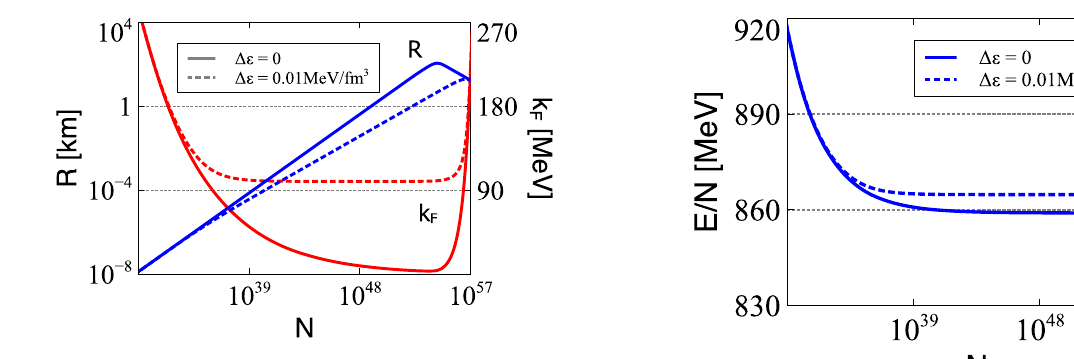
Fig. 4 The radius and Fermi momentum as a function of N at fixed Δ(cid:8) . Note that N (cid:2) M / M (cid:2) 1 . 2 × 10 57 Sun Sun Nucleon E surface with respect to the surface thickness d and the radius R at a fixed value of the total number of Λ ’s in the bubble.